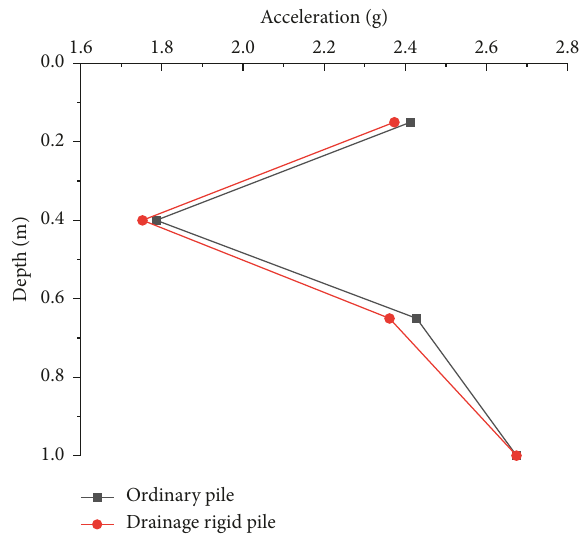
Figure 13: The variation pattern of the peak vertical acceleration along the depth on both sides of the ordinary pile and drainage rigid